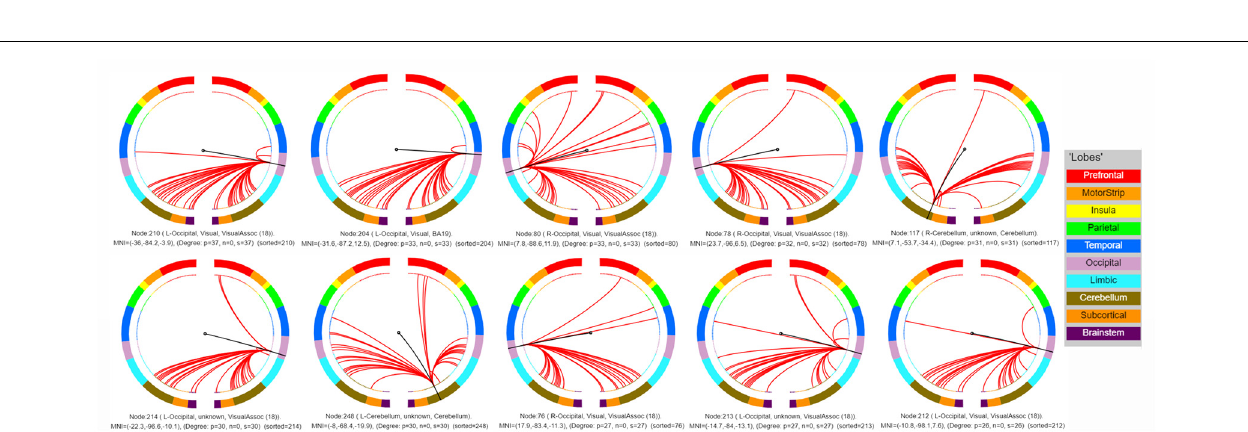
FIGURE 3 | Connectivity patterns of the top 10 nodes with the most connections. L, left; R, right.